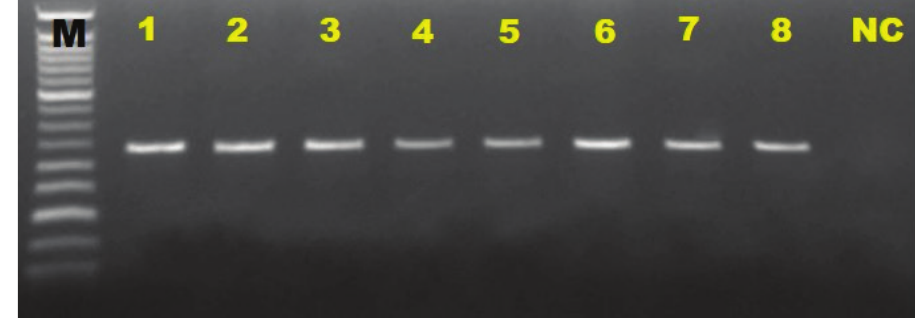
Figure 2: Electrophoresis pattern of PCR amplification of the bovine FSHB gene. M: Marker; NC: negative